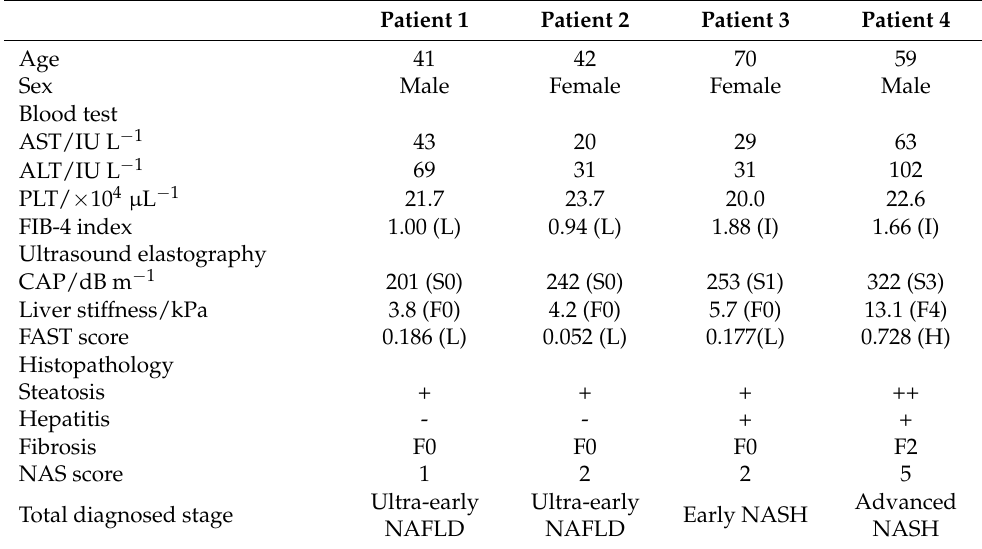
Table 1. Clinical and histopathological features of NAFLD